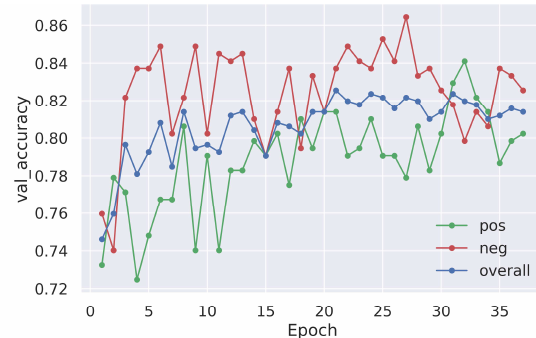
Figure 5. Accuracies on the validation set for the Twin network with a ResNet-50 backbone and ImageNet pre-trained weights.